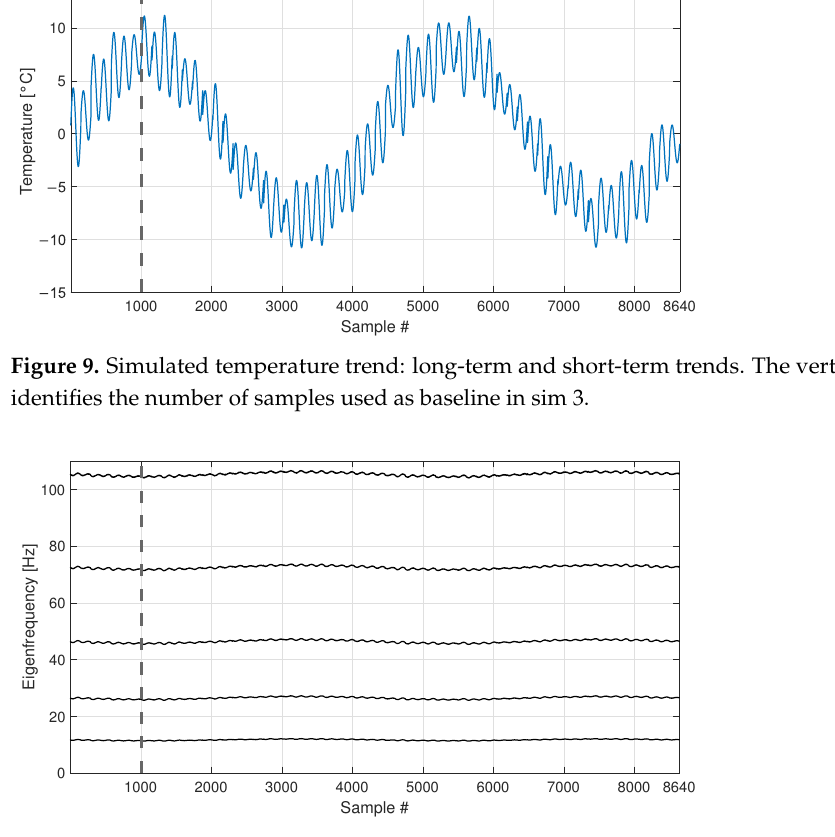
Figure 10. Simulated eigenfrequency trends related to long-term and short-term temperature trends. The vertical dashed line identifies the number of samples used as baseline in sim